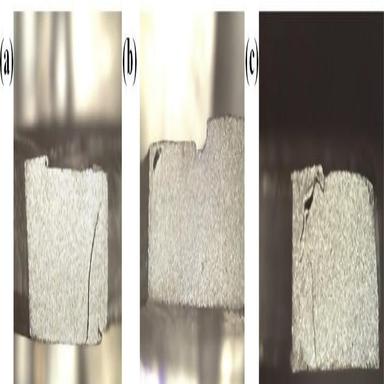
Macrographs of the FWTPET specimen showing (a) root side de-bonding (b) ring tunnel, (c) cavity and excessive flash.